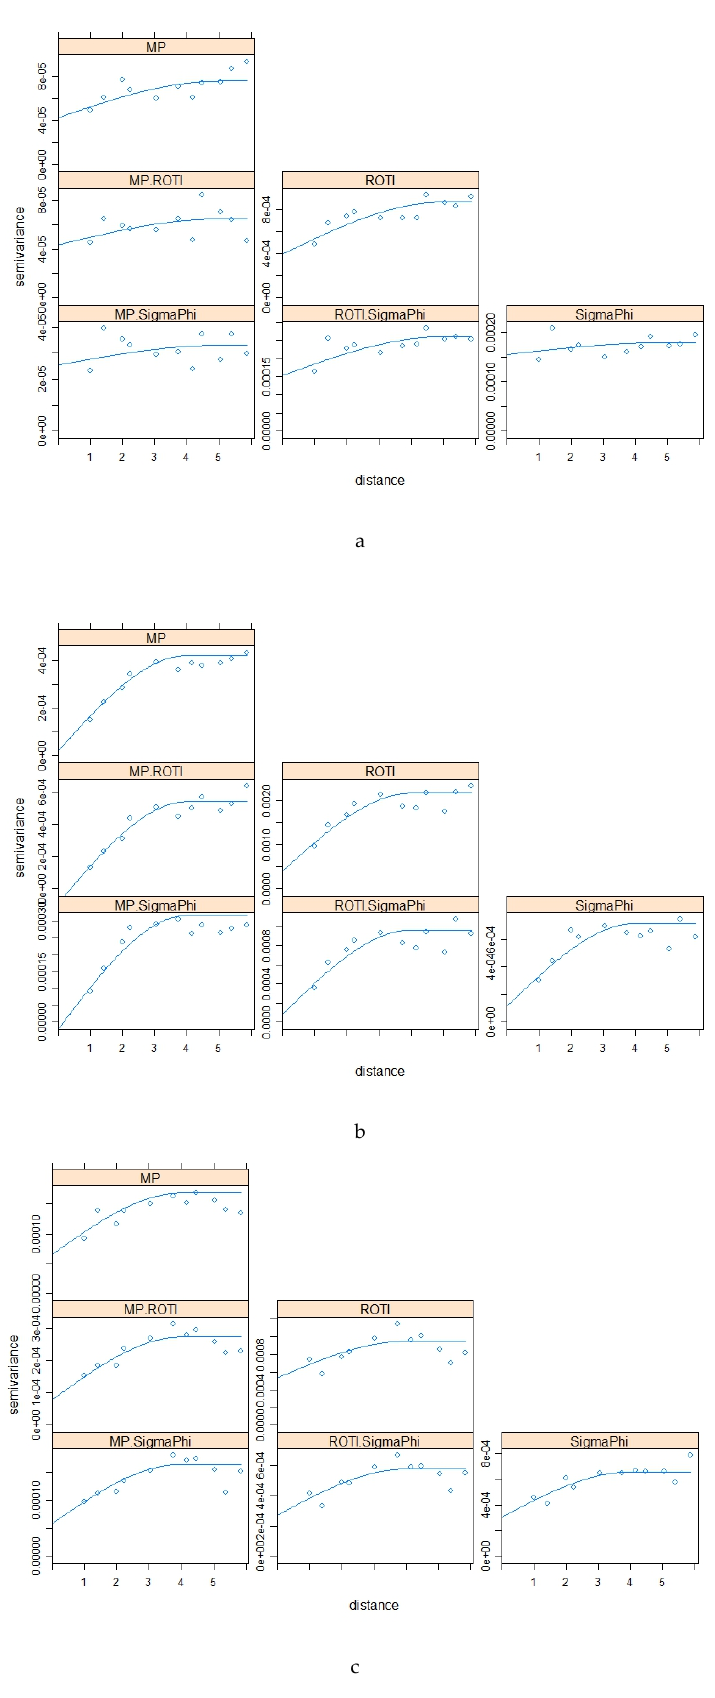
Figure 14. Figure 14a–c shows the variograms and cross-variograms associated with Figure